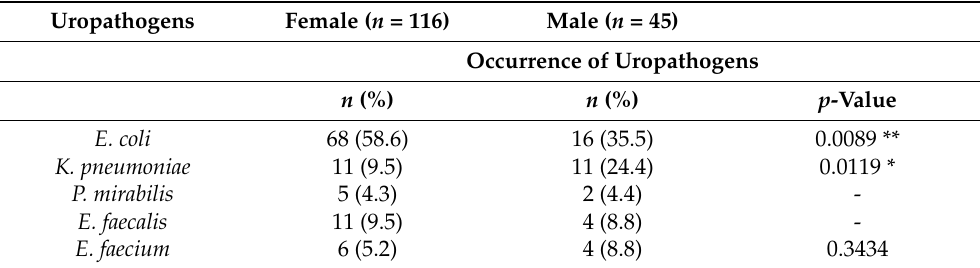
Table 3. The occurrence of the most common uropathogens in women and men hospitalized in different hospital